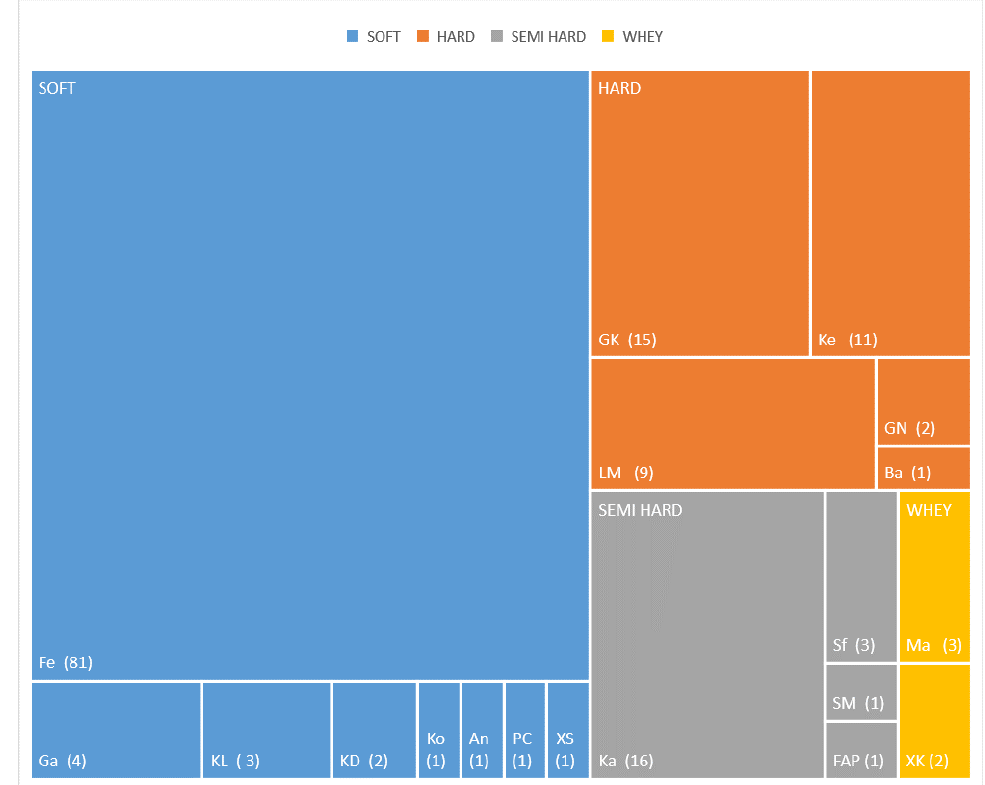
Figure 4. Tree map of the distribution of Greek “Quality label” cheese products identified in the retail market and grouped per cheese and firmness category. Fe: Feta PDO, KL: Kalathaki Limnou PDO, Ga: Galotyri PDO, KD: Katiki Domokou PDO, Ko: Kopanisti PDO, An: Anevato PDO, PC: Pichtogalo Chanion PDO, XS: Xigalo Siteias PDO, GK: Graviera Kritis PDO, GN: Graviera Naxou PDO, Ke: Kefalograviera PDO, LM: Ladotyri Mytilinis PDO, Ba: Batzos PDO, Ka: Kasseri PDO, Sf: Sfela PDO, SM: San Mihali PDO, FAP: Formaella Arachovas Parnassou PDO, Ma: Manouri PDO, XK: Xinomizithra Kritis PDO.